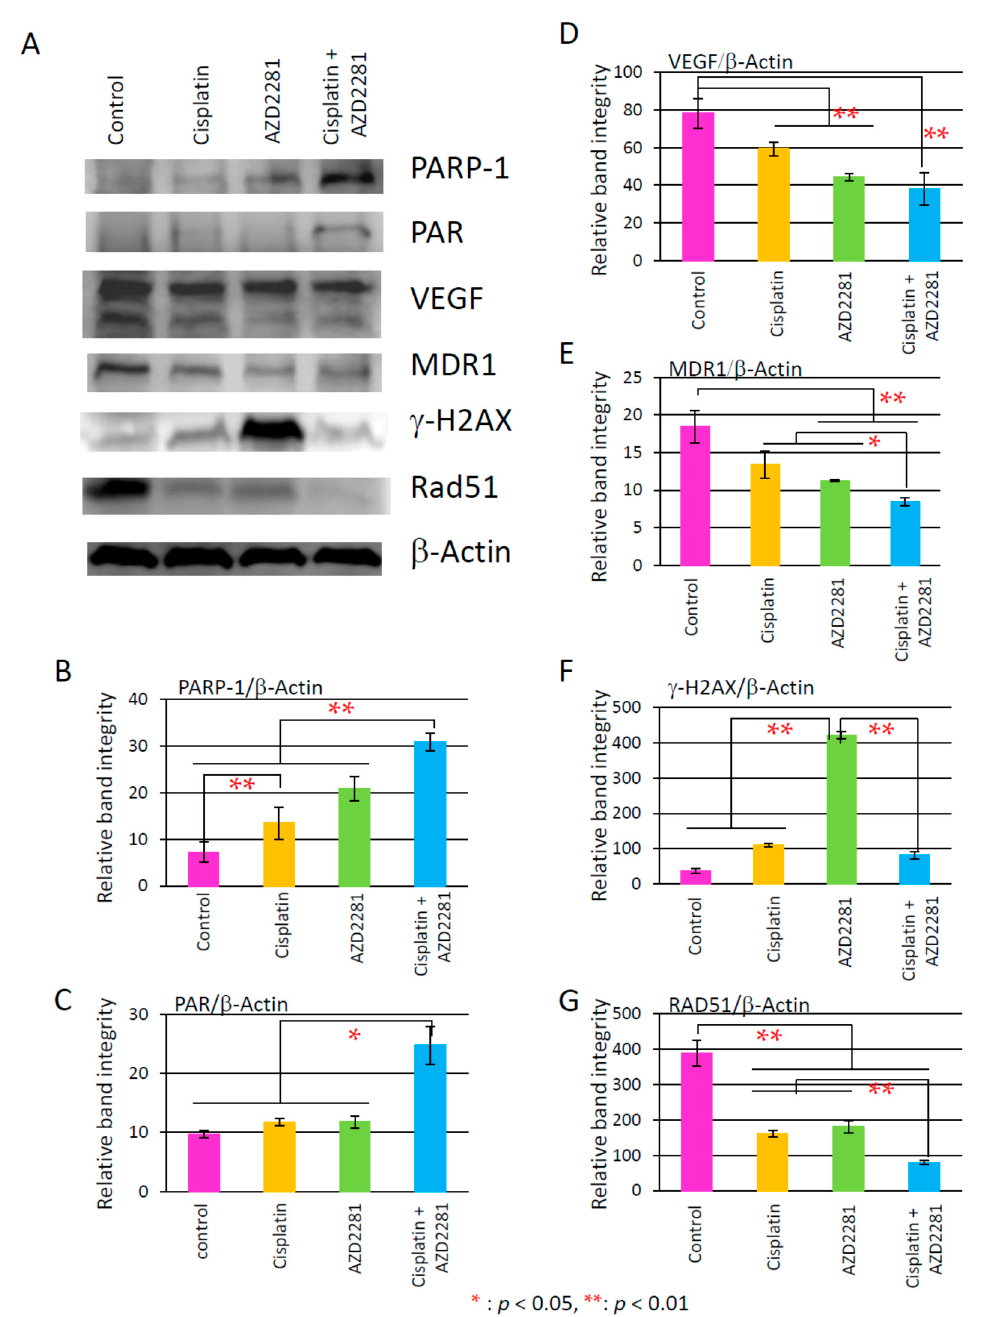
Figure 8. ( A ) The effect of cisplatin and AZD2281 on the protein expression of xenografted HSC-2 tumors. Relative band intensity of western blot data was normalized by the expression level of β -actin; The proteins analyzed were PARP-1 (poly(ADP-ribose) polymerase-1) ( B ); poly(ADP-ribose) (PAR) ( C ); vascular endotherial growth factor (VEGF) ( D ); multi-drug resistance gene 1 ( MDR1 ) ( E ); γ -H2AX ( F ); and RAD51 ( G ). Values are expressed as the mean ± SEM. * p < 0.05; ** p < 0.01.